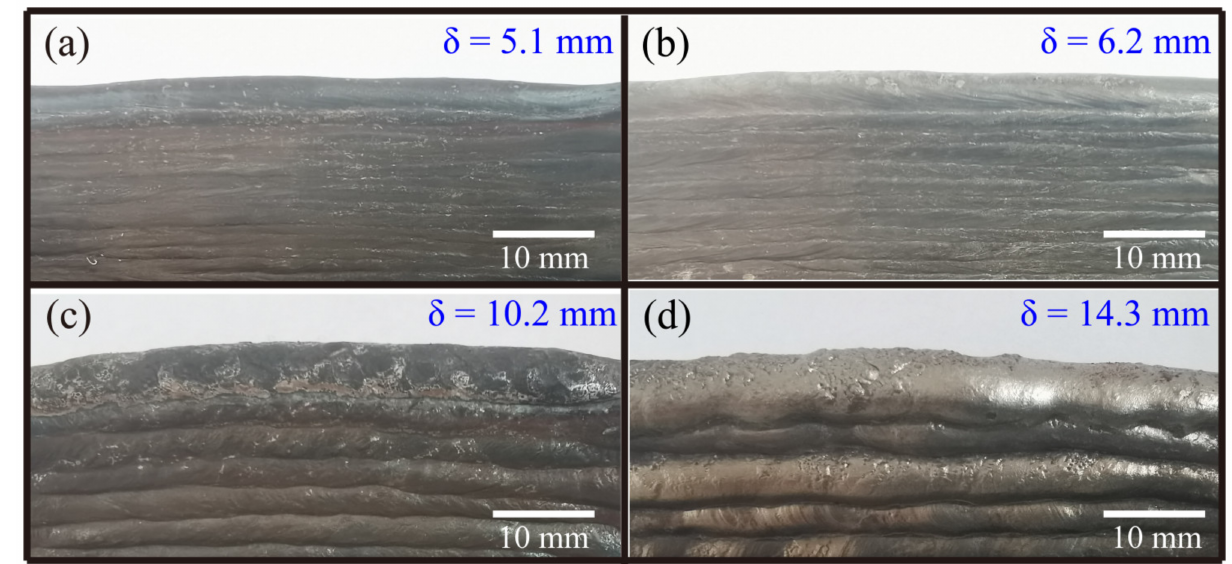
Figure 4. Photographs of the sidewall forming of the deposited wall with different thicknesses: ( a ) δ = 5.1 mm, ( b ) δ = 6.2 mm, ( c ) δ = 10.2 mm, and ( d ) δ = 14.3